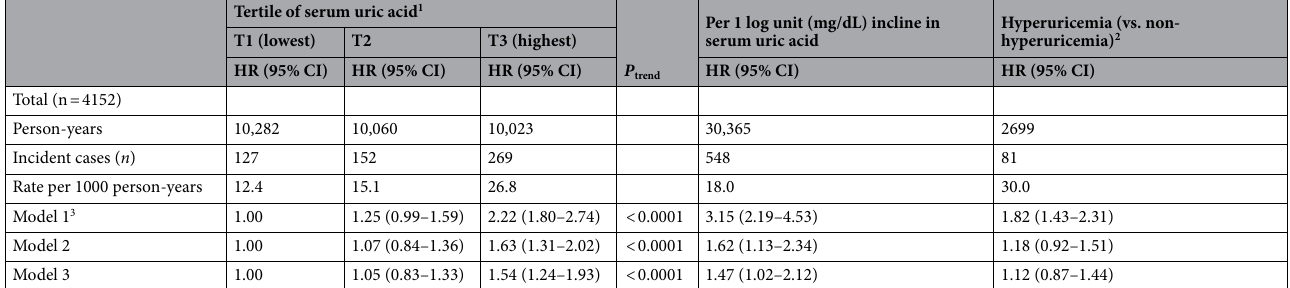
High inflammation 2 (vs.